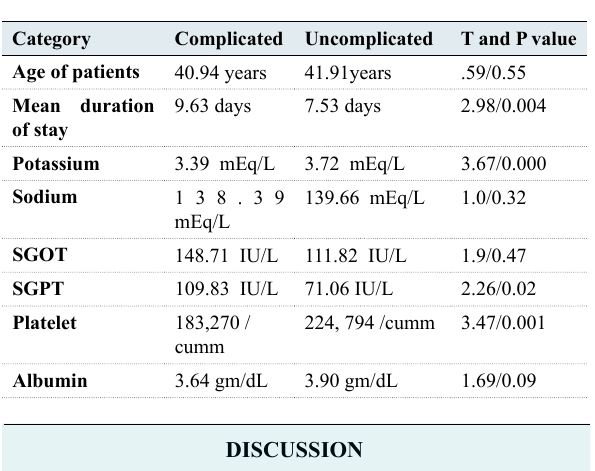
Table 4: Mean duration and other laboratory parameters among complicated and uncomplicated alcohol dependence syndrome